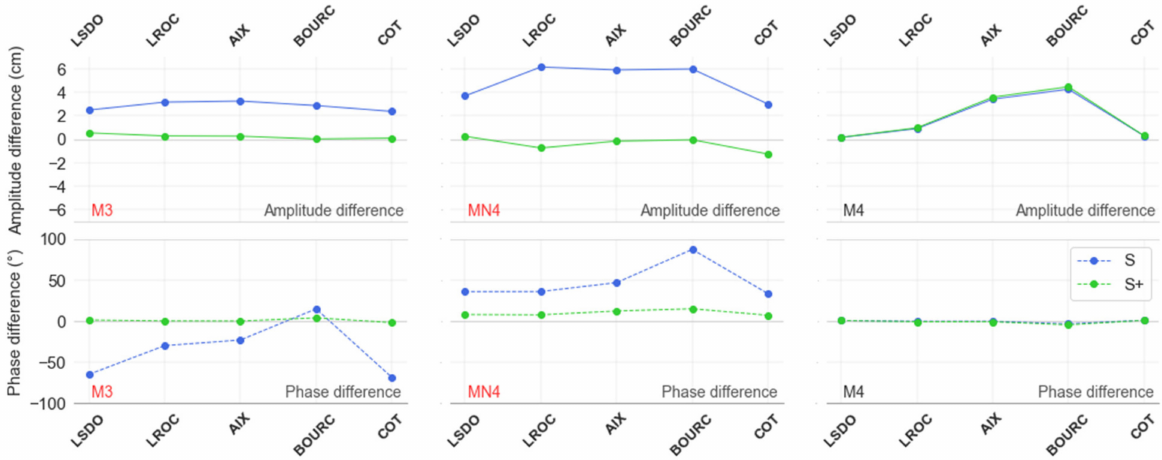
Figure 8. Amplitude and phase differences between observed and modelled M3, MN4 and M4 at the 5 stations. Amplitude ( top panel ) and phase differences ( bottom panel ) at the 5 stations are computed for S (blue) and S+ (green) configurations. Red labels correspond to constituents for which an empirical bias has been applied on the S+